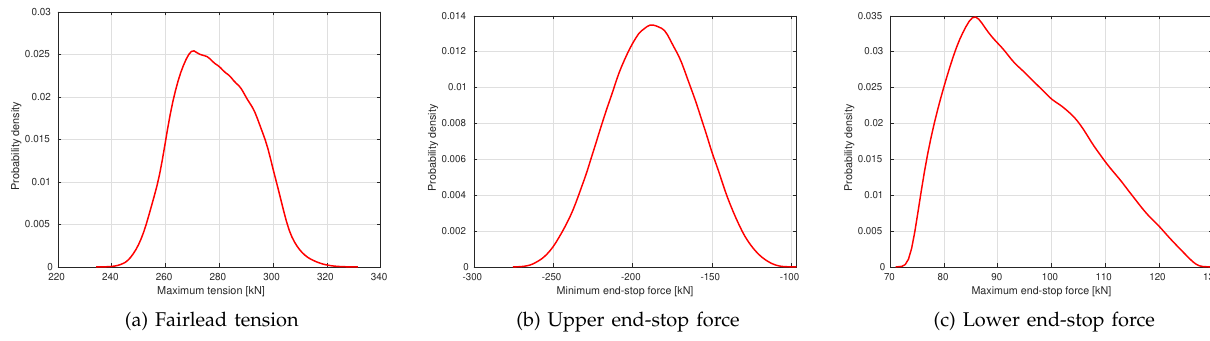
Fig. 11. PDFs for the SS1 case using d = 5 .